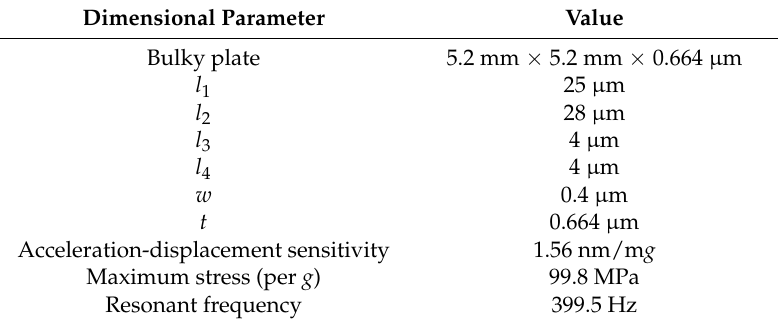
Table 3. Dimensional and performance parameters of the mechanical design.